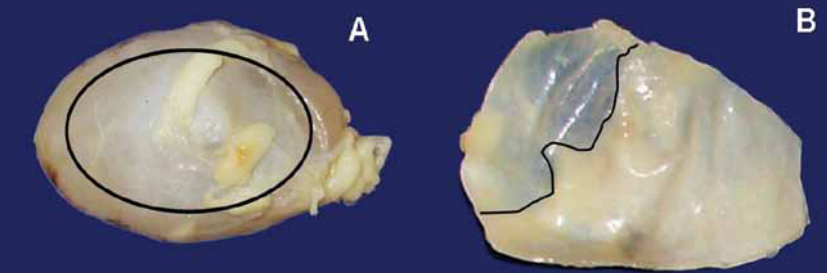
Figure 1 - Macroscopic evaluation of the latex biomembrane: (A) spherical architecture (exterior); (B) border between the native and new tissues